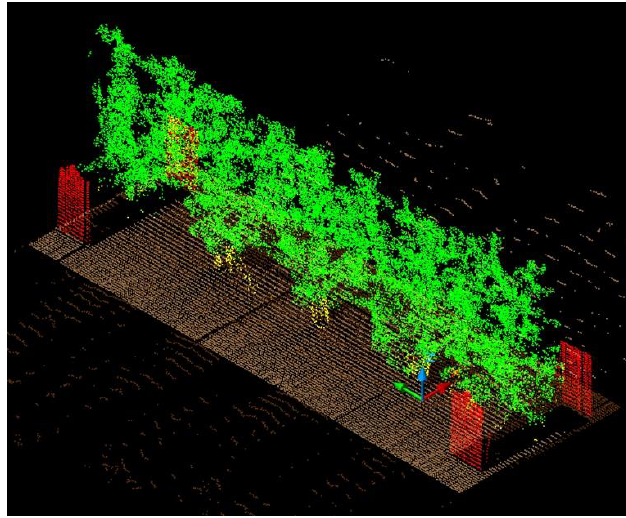
Figure 19. Point cloud obtained after registration of the scans of the left and right sides of Section